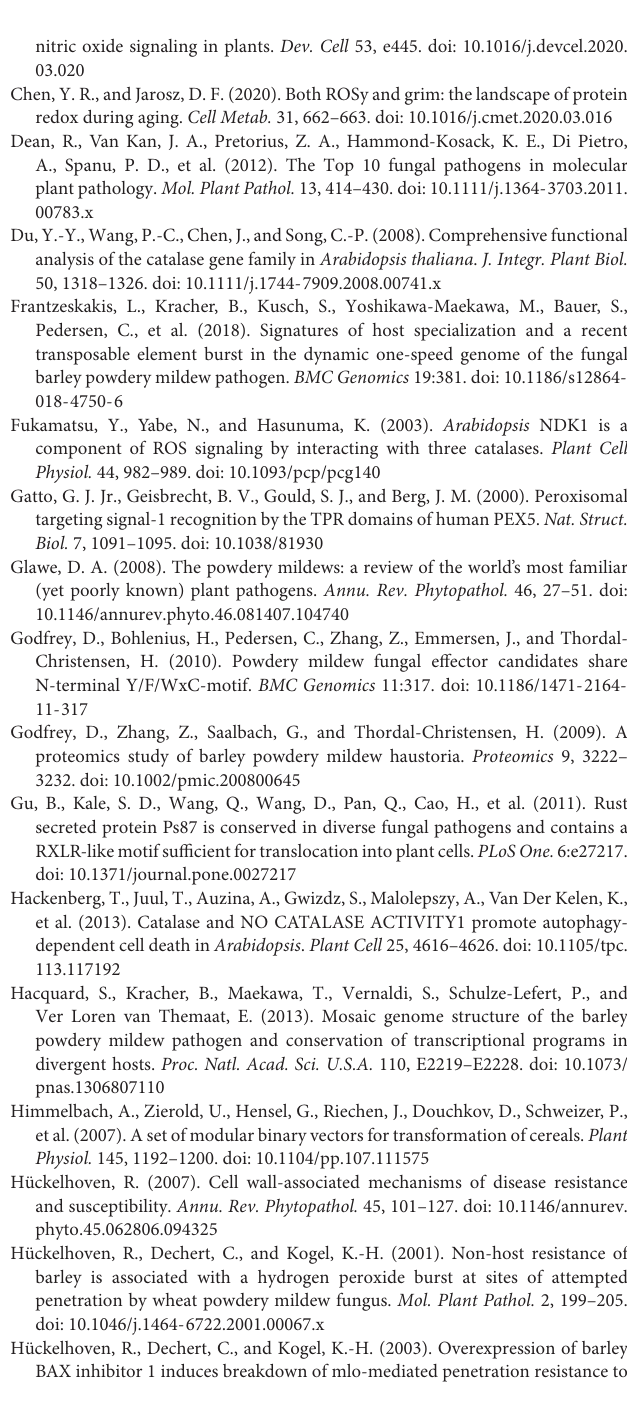
indicates a C-terminal conserved cysteine. (B) Expression of CSEP0027 and its Bgt homologs in N. benthamiana . The experimental procedure used here was the same as that in Figure 1A . Supplementary Figure 4 | Sequence alignment of amino acids of Hv CAT1 and Hv CAT2. Supplementary Figure 5 | CSEP0027 N-terminus interacts with Hv CAT1 in yeast. (A) Schematic diagram of Hv CAT1 constructs, and Hv CAT1-NT (1–401)